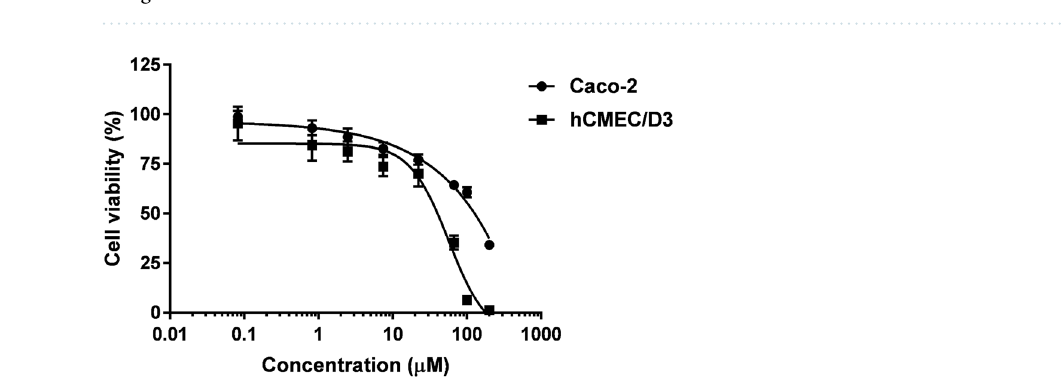
Figure 7. Isobolograms for combinations of compound 14 with teicoplanin and vancomycin tested at various ratios against Acinetobacter baumannii ATCC BAA1605, Escherichia coli ATCC 25218 and Pseudomonas aeruginosa ATCC 27853.